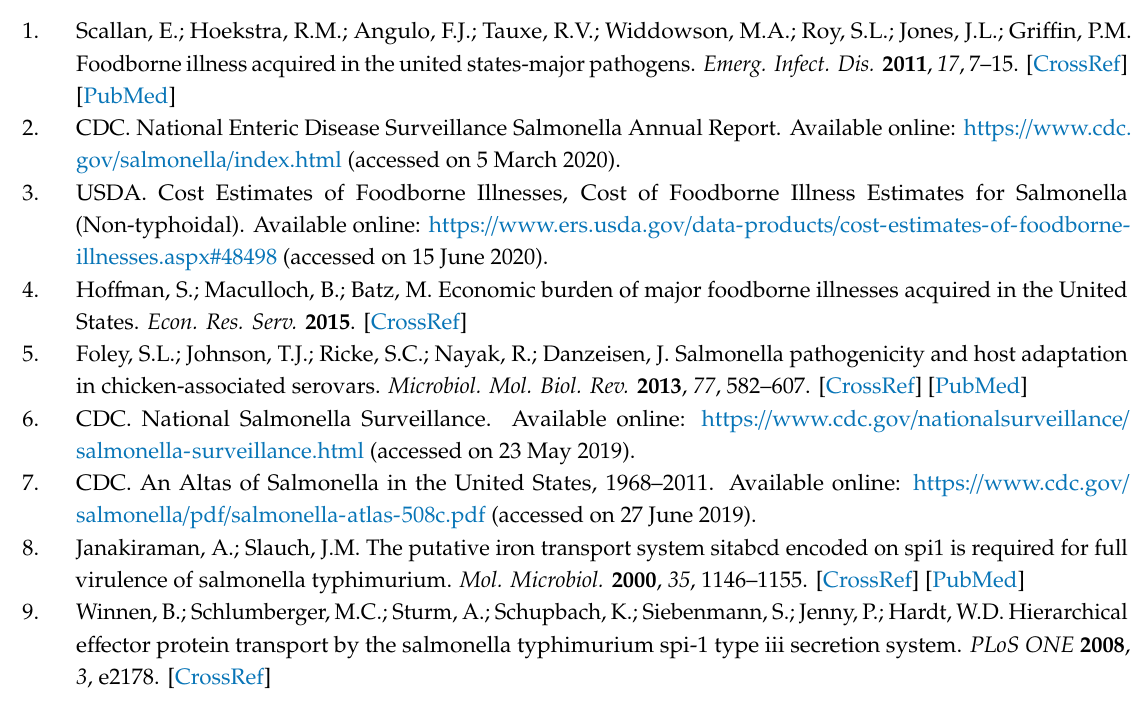
Figure S1: SNP-based phylogenetic tree analysis for 79 S . Typhimurium. The isolate number / names are followed by the year of isolation, Table S1: Iron acquisition system genes and SPI-1 and SPI-2 encoded T3SS genes found in the 71 S. Typhimurium isolates using PATRIC, Table S2: Additional reference S. Typhimurium isolates including their plasmid types and antimicrobial resistance genes of the more recently sequenced, Table S3: Spreadsheet displaying the results of the NCTR Virulence Factor Database gene detection for the S. Typhimurium isolates included in the